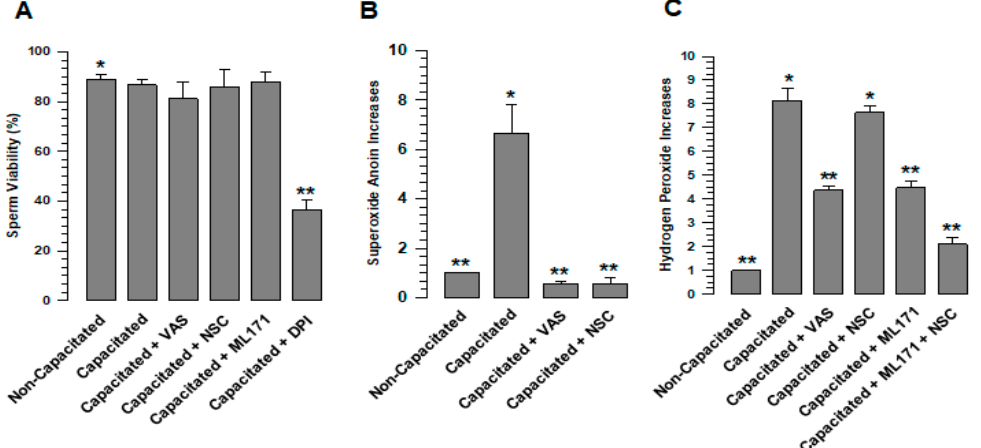
Figure 2. ROS production in sperm increases during capacitation. The status of ROS production was determined in guinea pig spermatozoa; they were capacitated for 60 min in the absence and presence of VAS (VAS2870 40 µM) or NSC (NSC23766 100 µM) or/and ML171 (2 µM), then O 2• - and H 2 O 2 were assessed. ( A ) VAS2870, NSC23766, and ML171 did not alter sperm viability. ( B ) Increase in O 2• - production during capacitation. ( C ) Increase in H 2 0 2 production during capacitation. The results are expressed in the ratio N/N0, where N is the total amount of O 2• - or H 2 O 2 produced in each assay and N0 is the total quantity of O 2• - or H 2 O 2 produced by non-capacitated assay. Results are expressed as the mean ± S.E. ( n = 3). Differences were considered significant when p ≤ 0.05, com- paring (*) concerning (**).